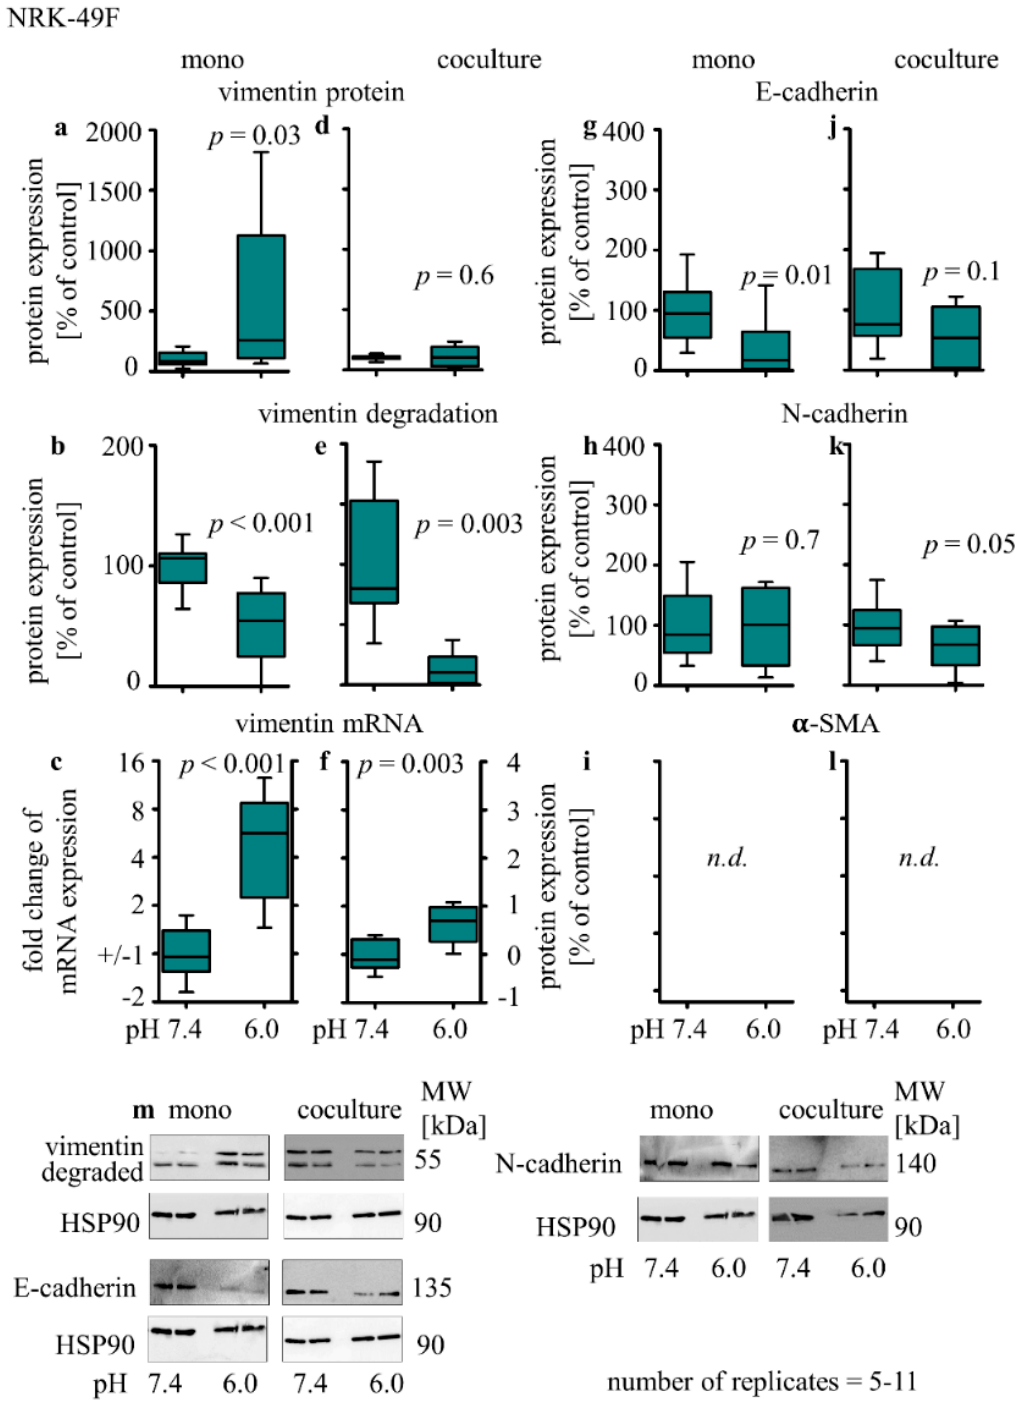
Figure 5. Acidosis effect on EMT markers in NRK-49F cells in mono- and co-cultures. Impact of acidosis on vimentin ( a , d ), E-cadherin ( g , j ), N-cadherin ( h , k ) and α -SMA ( i , l ) protein expression changes, vimentin degradation ( b , e ) and relative changes of vimentin mRNA expression ( c , f ). Representative Western blots of proteins isolated from cells exposed to acidosis. ( m ) p < 0.05 at significant difference compared with the control group; n − (5 − 11). Exposure time = 48 h.